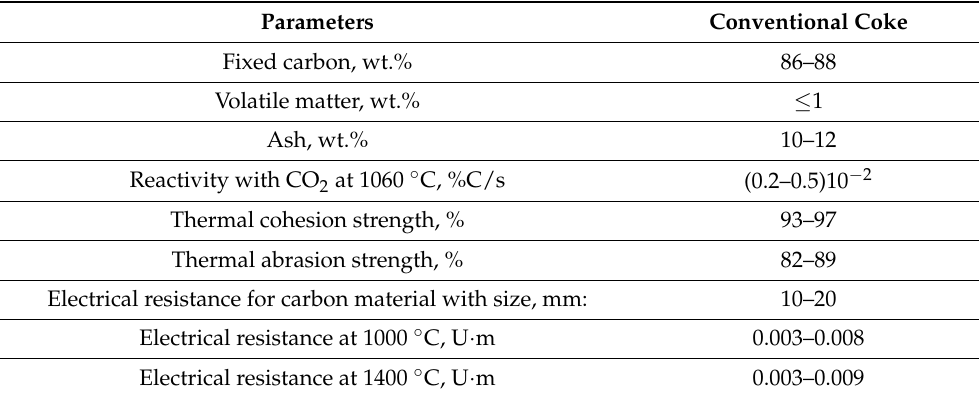
Table 9. Required properties for conventional coke in ferroalloy production [35,156]. Parameters Conventional Coke Fixed carbon,